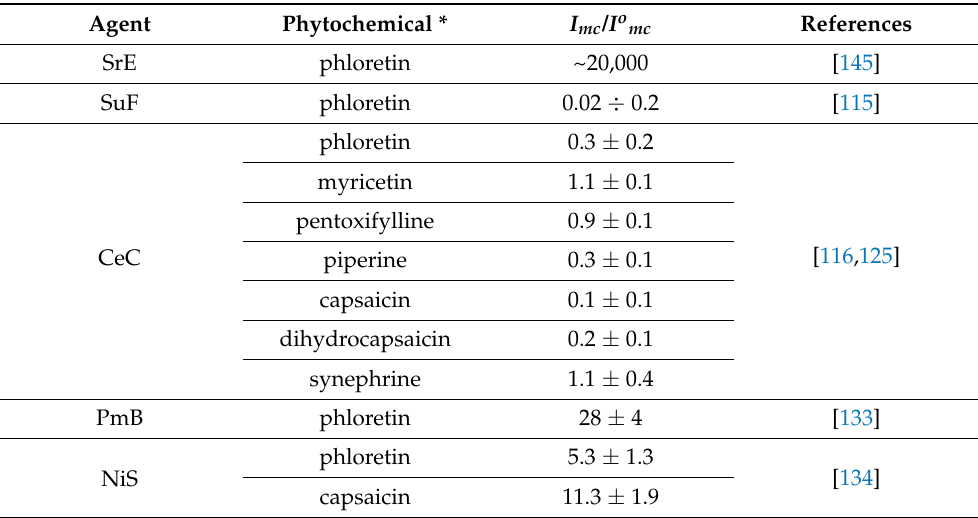
Table 3. The effects of phytochemicals on the multi-channel activity of anti-microbial agents: